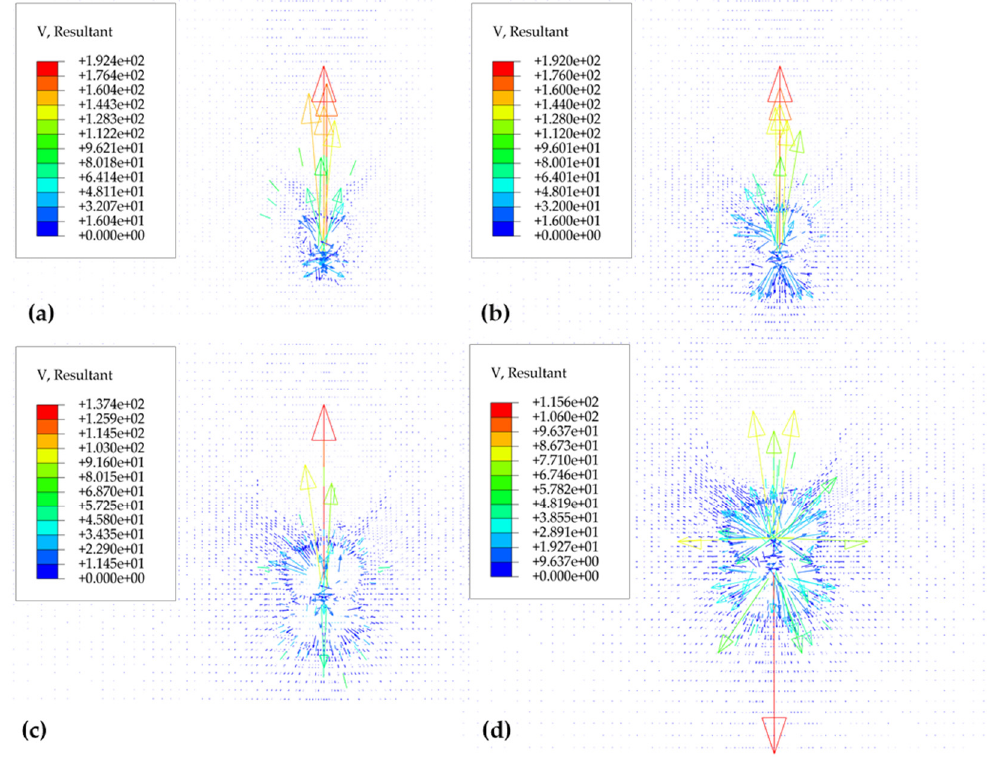
Figure 30. Velocity field in the bubble area during the collapse phase at: ( a ) t = 5.80 ms; ( b ) t = 5.85 m; ( c ) t = 5.90 ms; and ( d ) t = 6.00 ms.